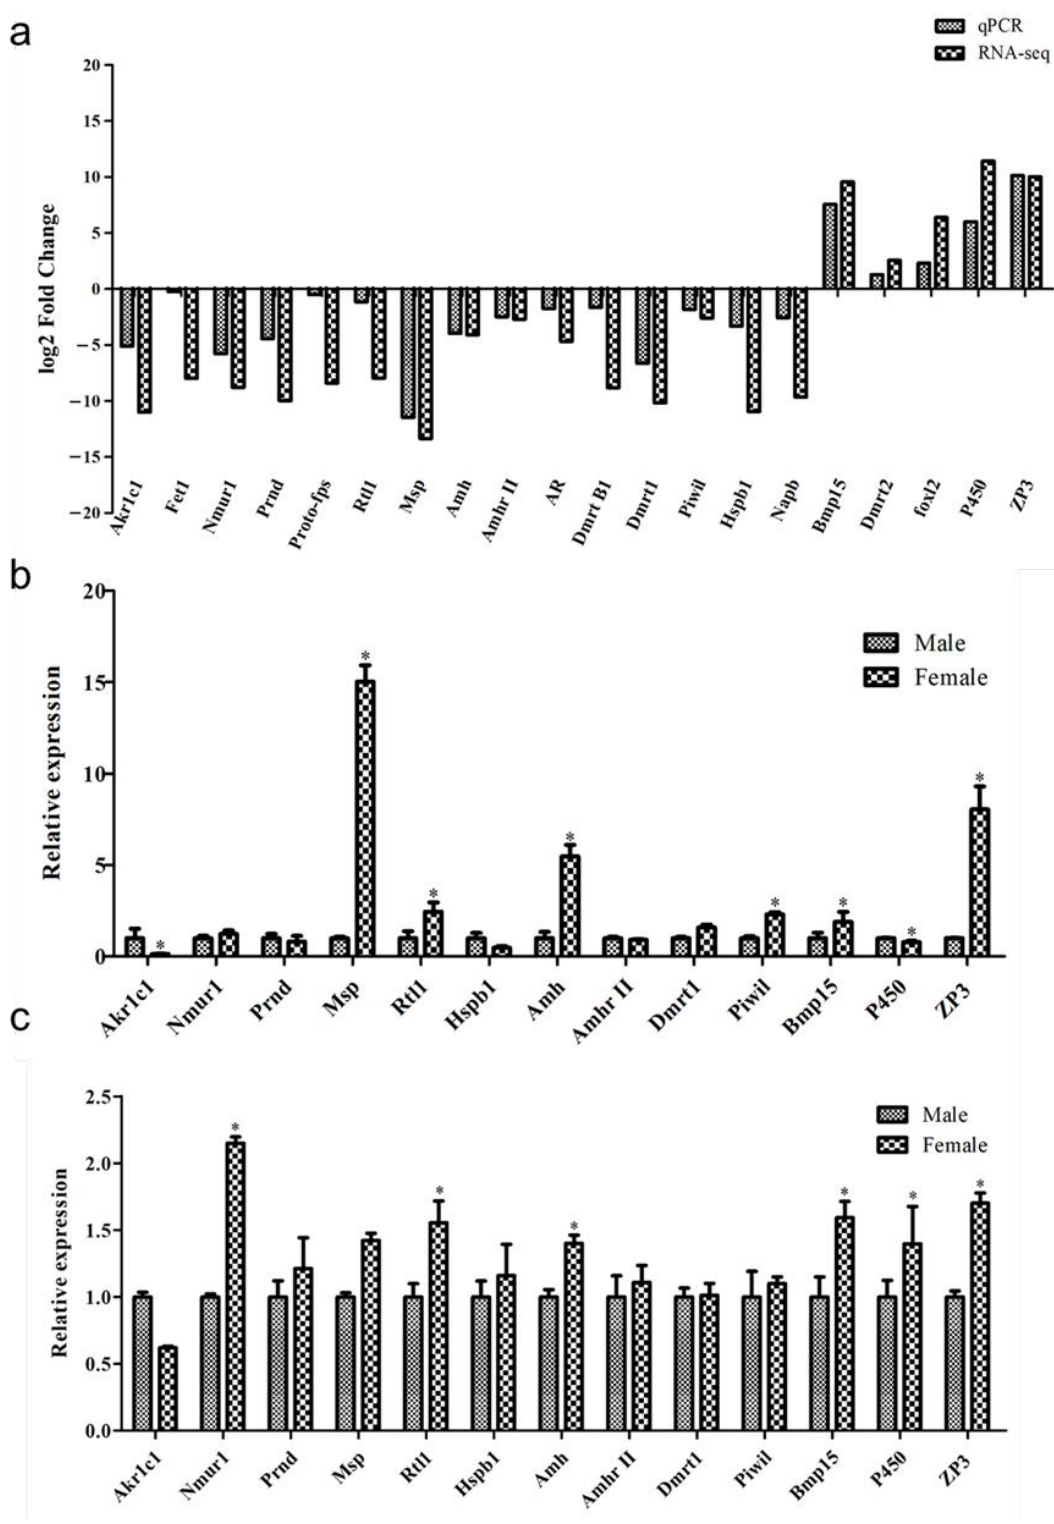
Figure 5. qPCR analysis of the DEGs in various tissues. ( a ) qPCR verification of the DEGs in the gonadal tissues of male and female Andrias davidianus . The y-axis is the log2 (relative expression of ovarian genes/relative expression of testicular genes). ( b ) The expression of the selected DEGs in the muscles of male and female CGSs ( n = 3; * p < 0.05). ( c ) The expression of the selected DEGs in the skin of male and female CGSs ( n = 3; * p < 0.05).